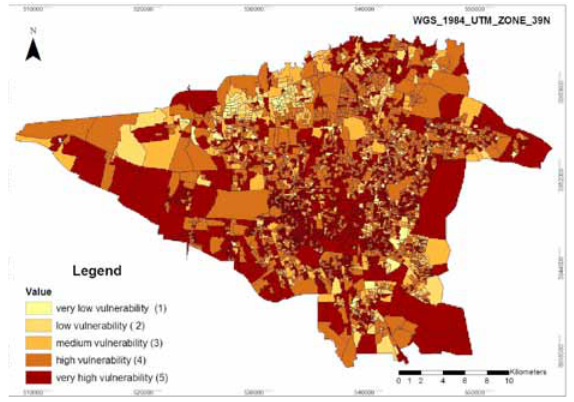
Fig. 6. Tehran’s seismic vulnerability map using association rules